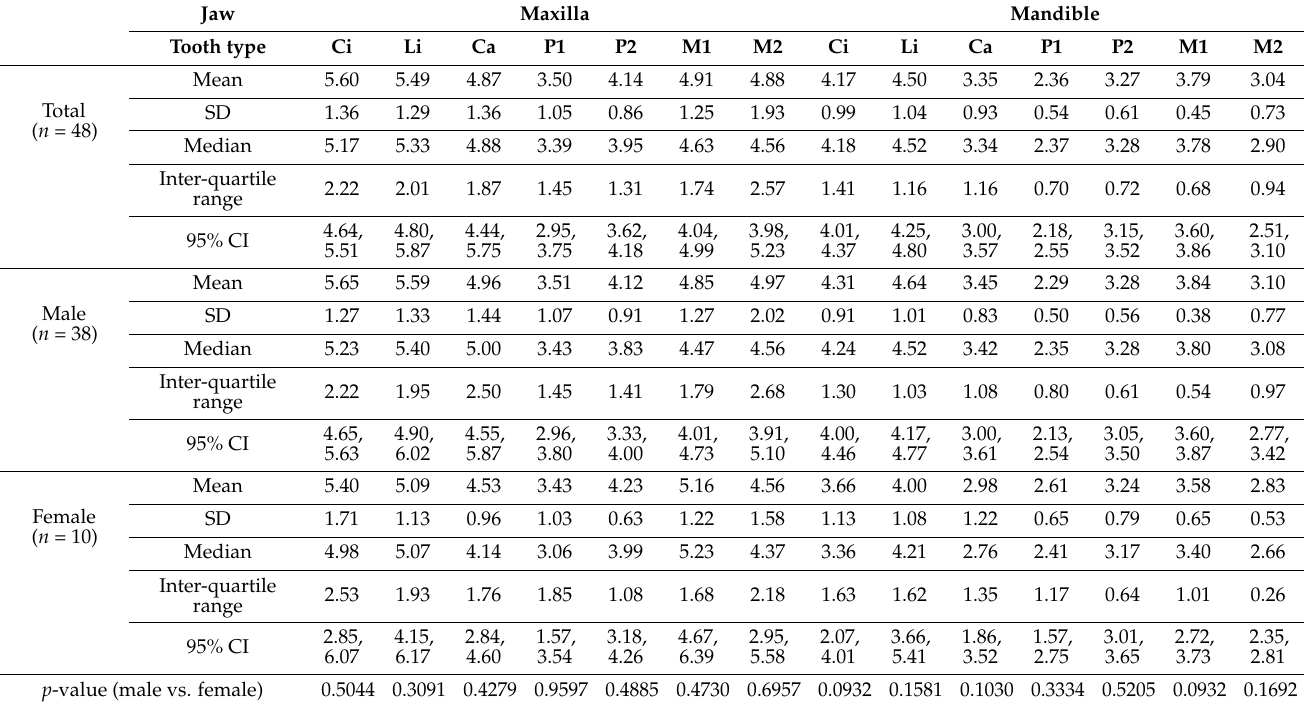
Table 1. Height of the keratinized gingiva (in